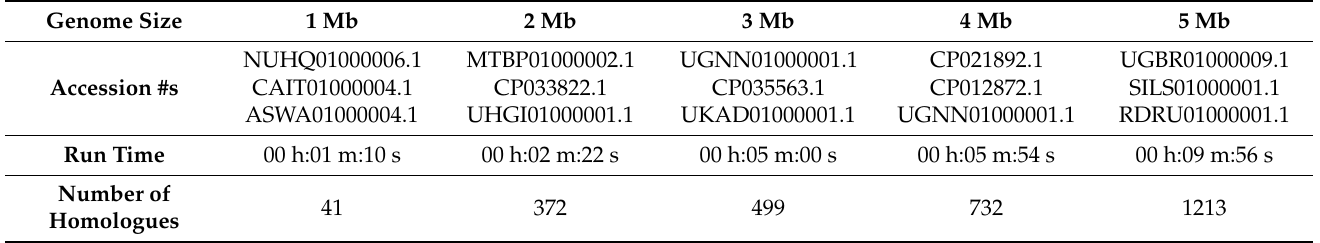
Table 2. CoreGenes5.0 analysis of three bacterial genomes. Five runs were completed, with different but uniform genome sizes for each run. The data were processed using the Bidirectional Best Hit method, paralog inclusion, and an e-value of 1 × 10 − 5